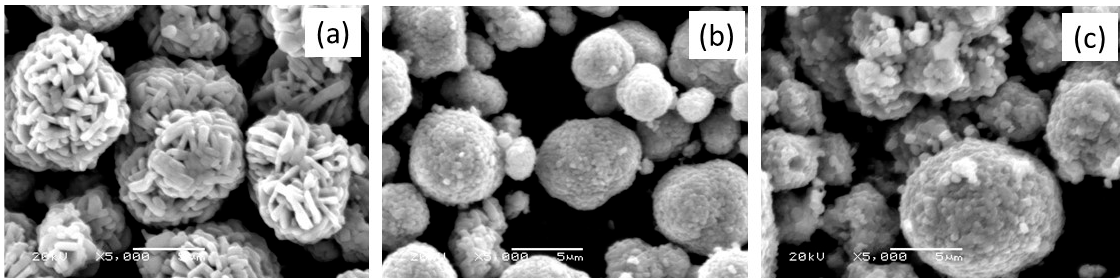
Figure 5. SEM images of NMC samples: ( a ) 333; ( b ) 442; and ( c ) 532 compounds prepared by solid-state reaction at 850 °C in air.